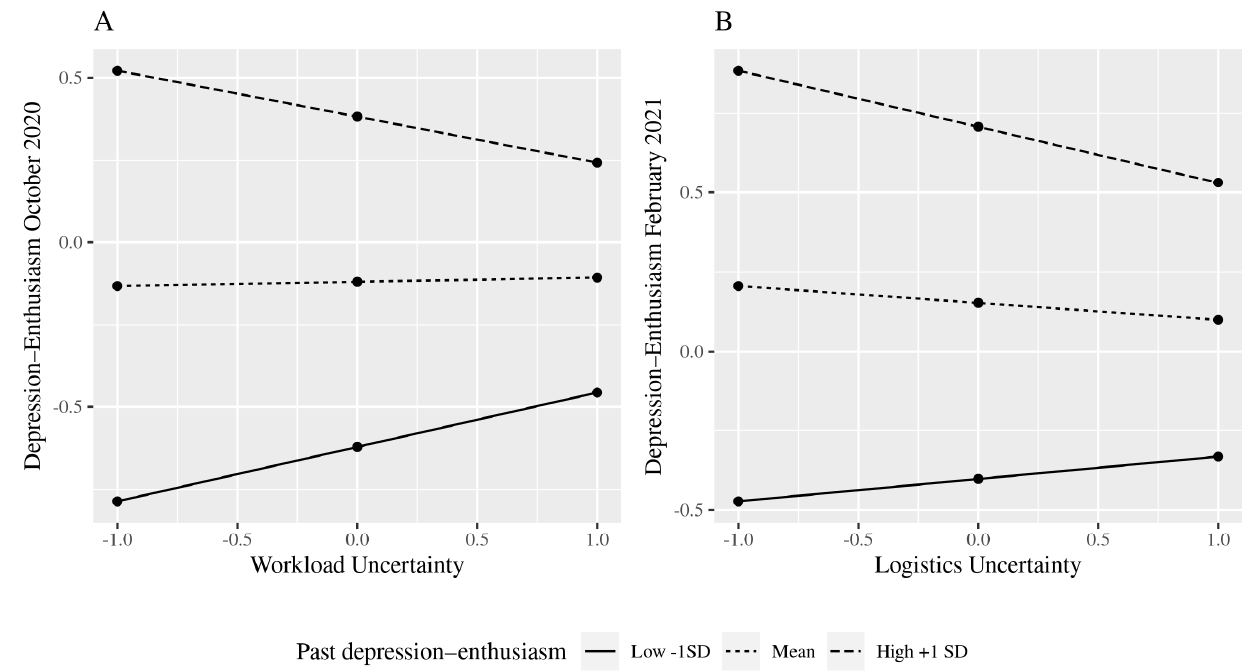
Figure 1. ( A , B ) Interaction effects between past anxiety–contentment and uncertainty.